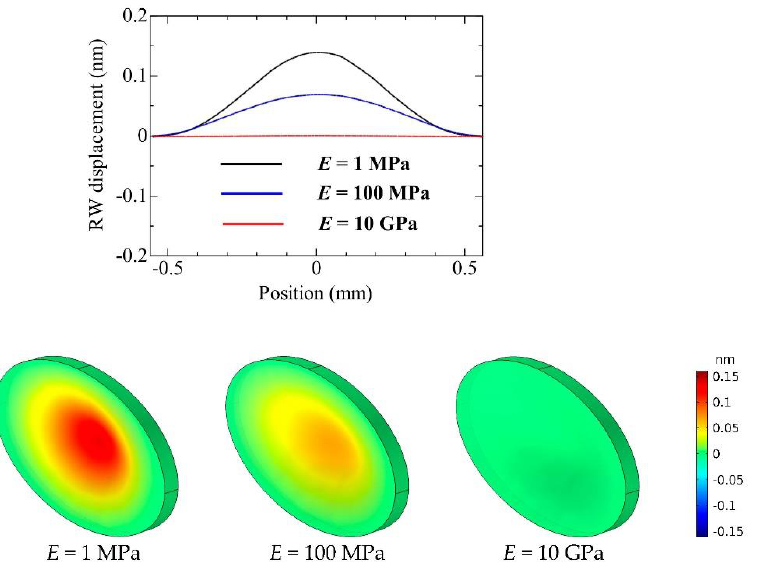
Figure 7. Displacements of the round window for three stages of round window atresia. The upper graph shows the maximum displacement of the elliptical round window membrane evaluated on its long axis. Position 0 mm corresponds to the center of the round window membrane. The lower ones also show the displacement of the round window membrane expressed by colors. A sinusoidal plane wave with a sound pressure level of 1 Pa and a frequency of 5000 Hz was set for the excitation.